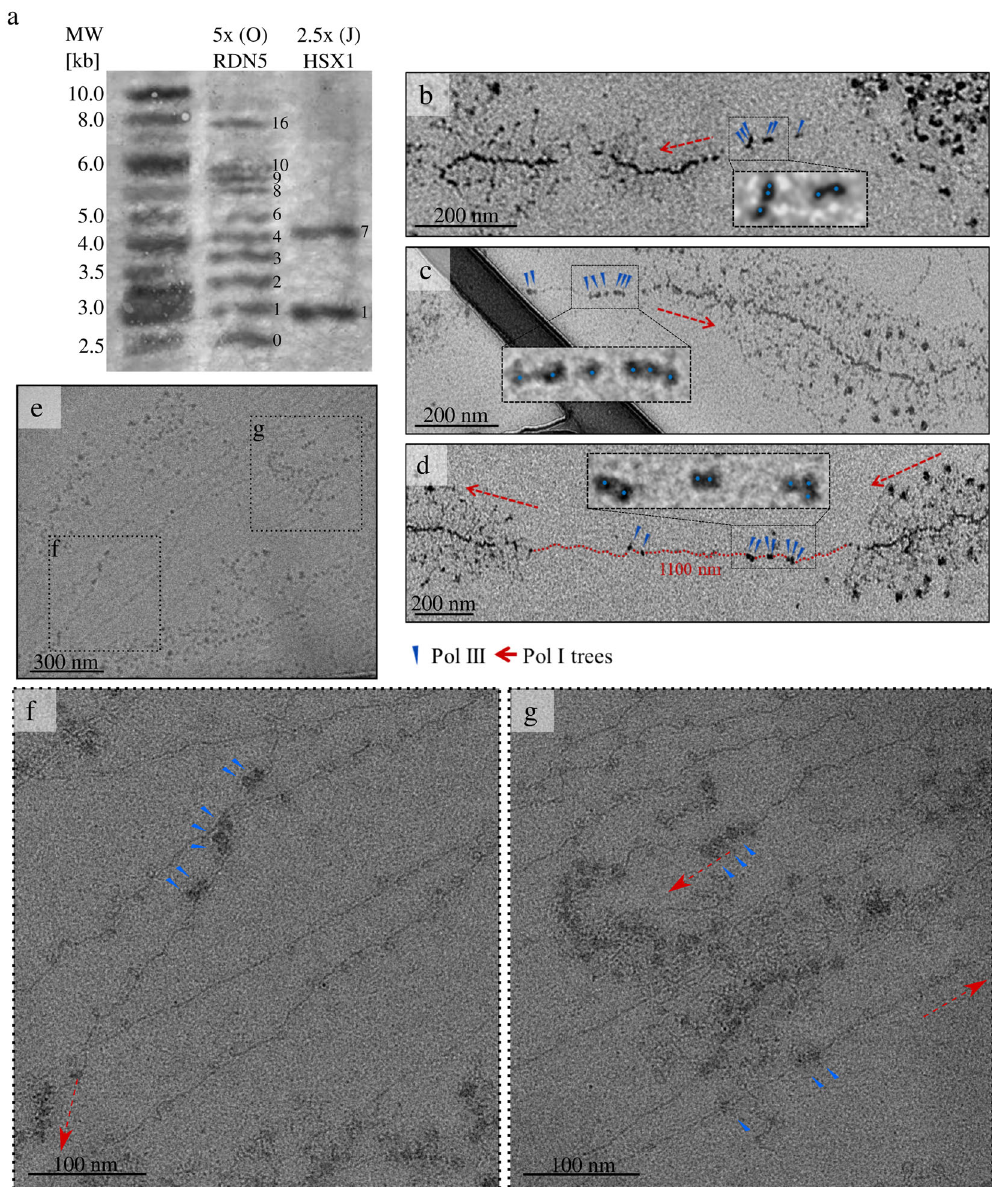
Fig. 2 Analysis of incorporated gene repeats. a Southern blot analysis of isolated genomic DNA from selected edited clones. Clones created in wild-type S. cerevisiae strain IMX672 background using editing condition 5x( RDN5 ) and 2.5x( HSX1 ) (see Supplementary Table 4). The Southern blot probe labels the genomic fragments with the endogenous copy of the Pol III-transcribed genes along with all inserted copies. The migration height of the band re fl ects the length of the incorporated copy cluster. After correction for intensity increase due to the higher probe-binding capacities of longer copy clusters, the band intensities can be used to approximate the prevalence of the copy number in relation to other number. We used KPL GeneRuler TM Biotinylated DNA Ladder. The band patterns are annotated with the corresponding copy number. The 5x(O) RDN5 band labeled ‘ 0 ’ derives from the empty repeat incorporation sites (the endogenous RDN5 copies are themselves part of the rDNA repeats). The clones are denoted with the incorporation condition (see Supplementary Table 4), a consecutive letter and the incorporated gene. b – d Miller trees in chromatin spreads of clone 2.5x(J) HSX1 with digitally enlarged regions showing Pol III complexes. The samples were positively stained with uranyl acetate (UA) and phosphotungstic acid (PTA); EM images were acquired at 12,000× magni fi cation at a defocus of ‒ 40 µ m. Red dashed arrows label the start or end of a Miller tree and its direction. Red dashed lines show the route of the DNA between Miller trees. d The length of the intergenic spacer is indicated in red. Blue arrowheads and blue points label Pol III complexes. e – g Miller trees in chromatin spreads of clone 5x(O) RDN5 . EM images of vitri fi ed sample were acquired at 11,500× magni fi cation at a defocus of ‒ 50 µ m and with 0.2 e ‒ /Å² total dose ( a ) or 105,000× magni fi cation at a defocus of ‒ 3 µ m and with 50 e ‒ /Å² total dose ( f, g ). Clone 5x(O) RDN5 contains up to 16 additional copies of RDN5 at each position between Miller trees. f Cluster of three incorporated RDN5 units with transcribing Pol III complexes. g Endogenous copy of RDN5 in close proximity to the start of a Miller tree (top) and two incorporated RDN5 copies with transcribing Pol III complexes